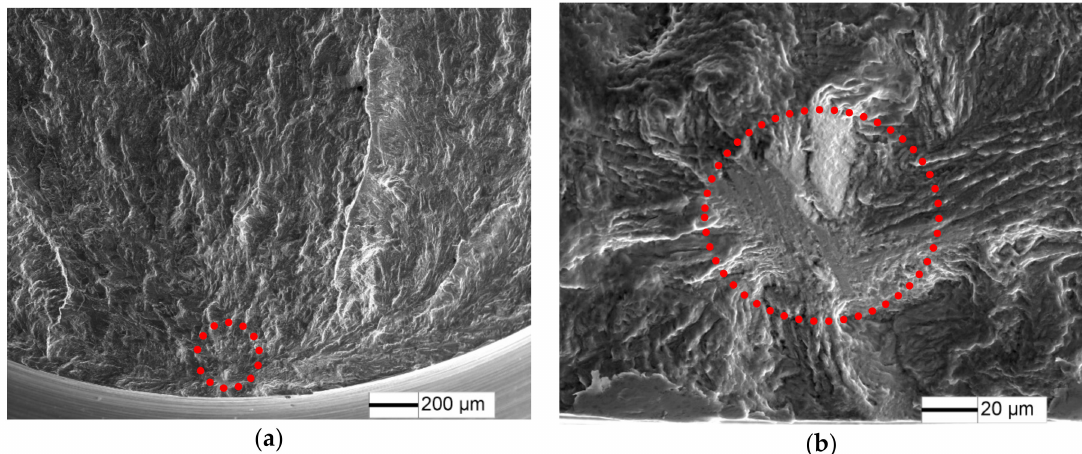
Figure 9. Fracture surface for the notch specimens at σ = 350 MPa and N = 3 × 10 6 cycles: ( a ) fatigue crack initiation site (remarked by red line), and ( b ) crack initiation morphology.